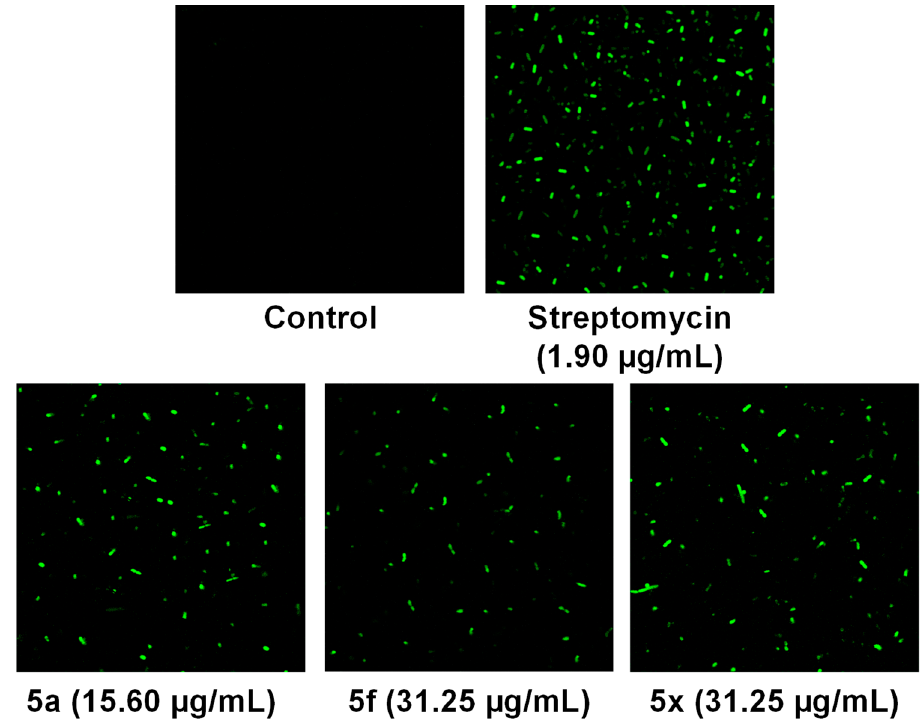
Figure 4. Detection of ROS generation of compounds 5a , 5f and 5x in E. coli .